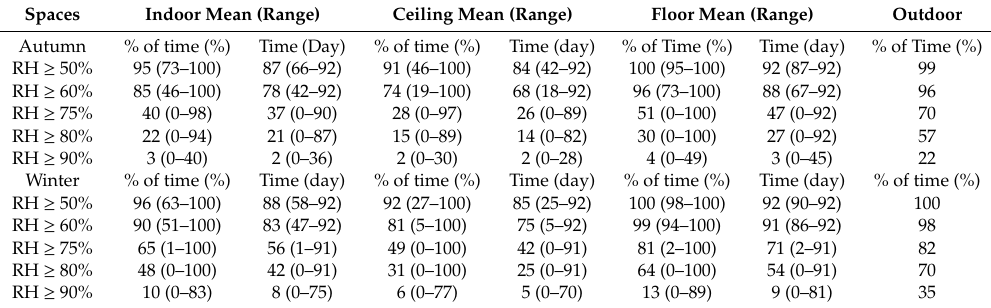
Table 3. Autumn and winter time related to di ff erent ranges of mean indoor relative humidity of the 16 sample houses in Minginui, Te Whaiti and Murupara.